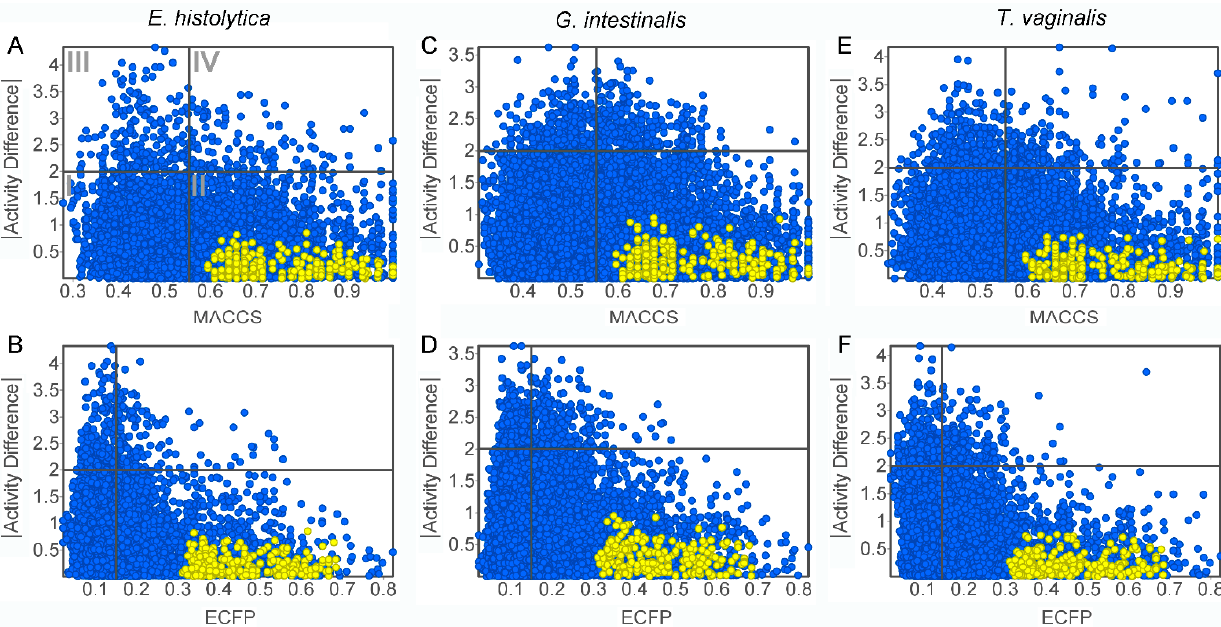
Figure 3. Structure-Activity Similarity Maps using Molecular ACCess System keys (MACCS) and Extended Connectivity Fingerprint (ECFP) divided by thresholds in structure similarity and activity differences in regions I–IV. Each data point indicates a pairwise comparison of the 22 synthesized 2-phenyl-2 H -indazole derivatives (231 datapoints in yellow, A – F ) and 111 benzimidazoles tested against E. histolytica (6105 datapoints in blue, A , B ), 159 benzimidazoles tested against G. intestinalis (12,561 datapoints in blue, C , D ), and 134 benzimidazoles tested against T. vaginalis (8911 datapoints in blue, E , F ).